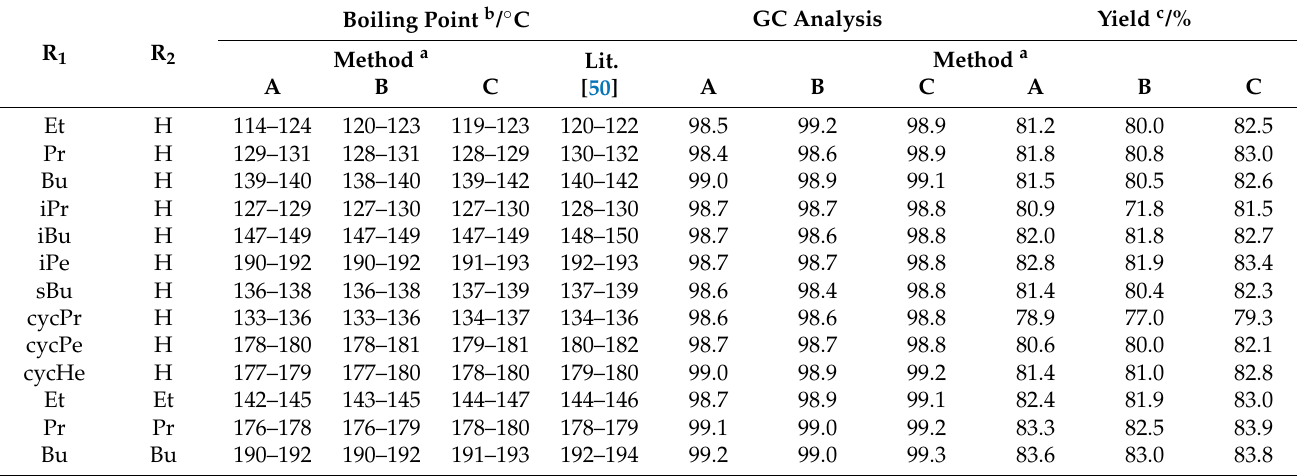
Table 2. Results of N -alkyl-, N , N -dialkyl-, and N -cycloalkyl- O -isobutyl thiocarbamate